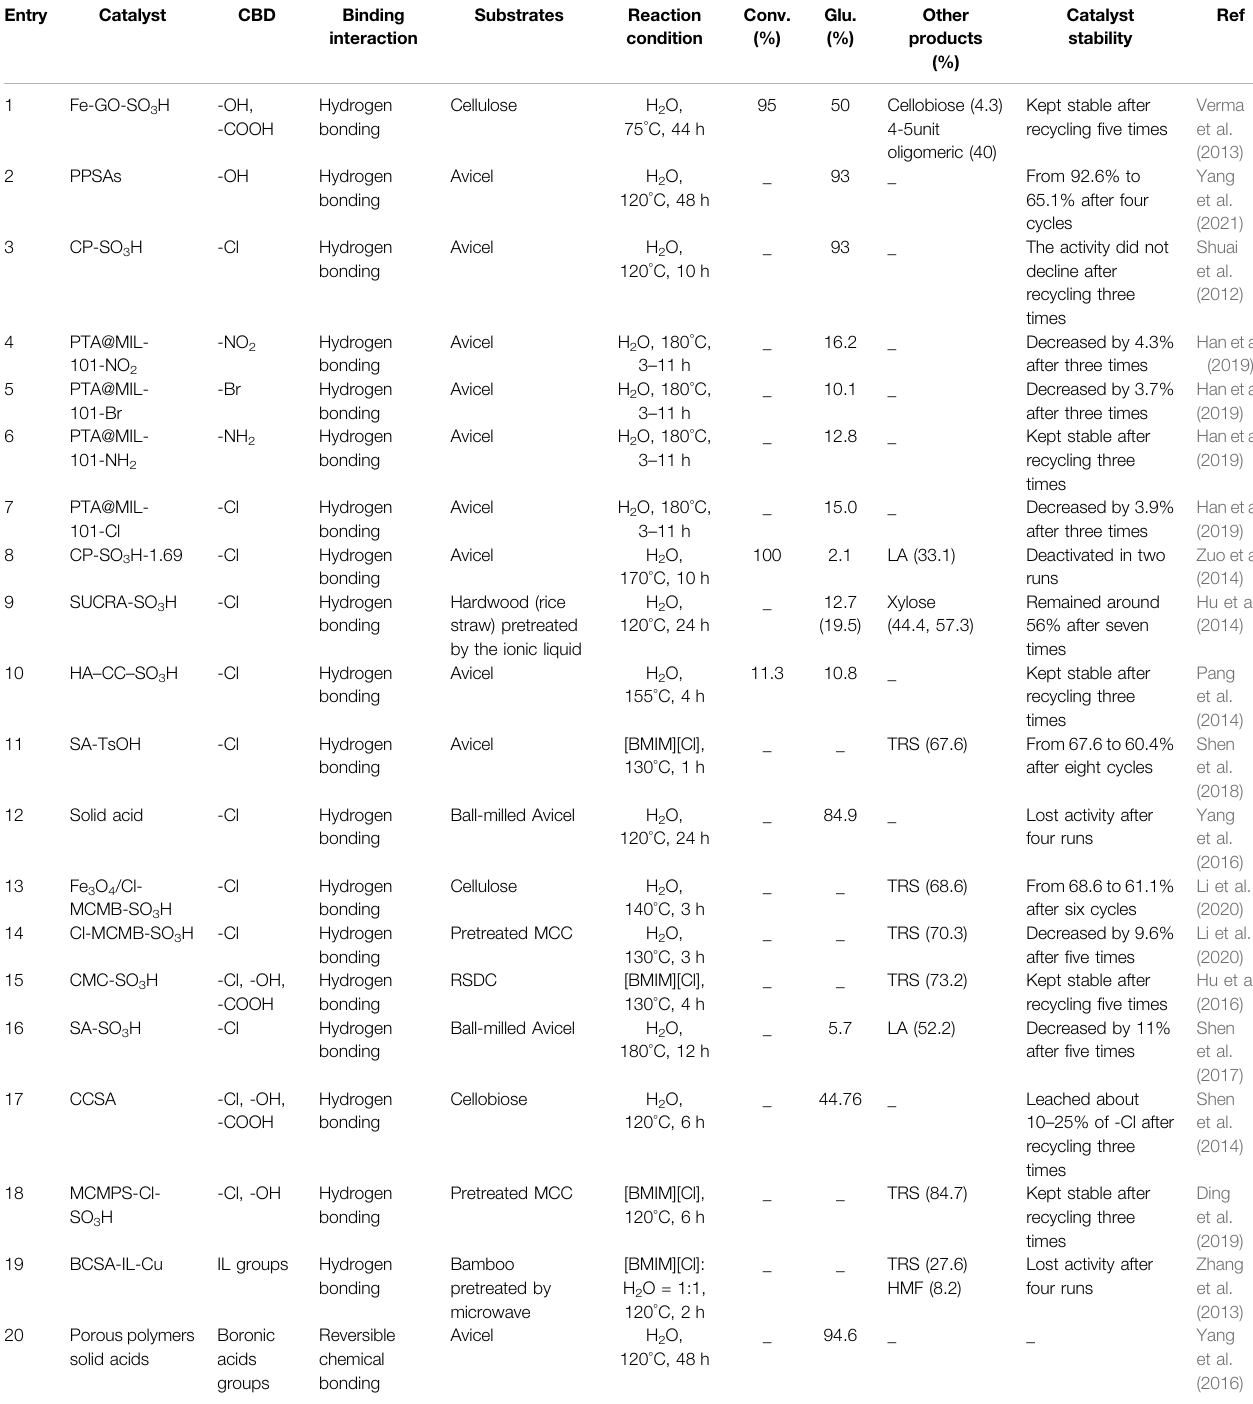
TABLE 1 | The catalytic performance of various cellulase-mimetic solid acids catalysts on hydrolyzing